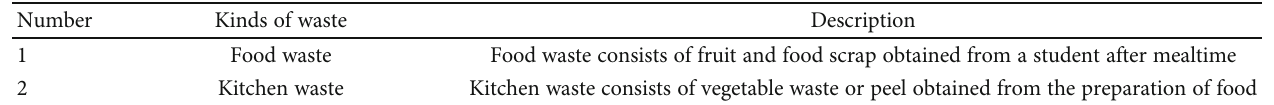
Figure 4: Food and kitchen waste removal in Atse Fasil Campus cafeteria. Table 1: Type of solid wastes available and its description in the